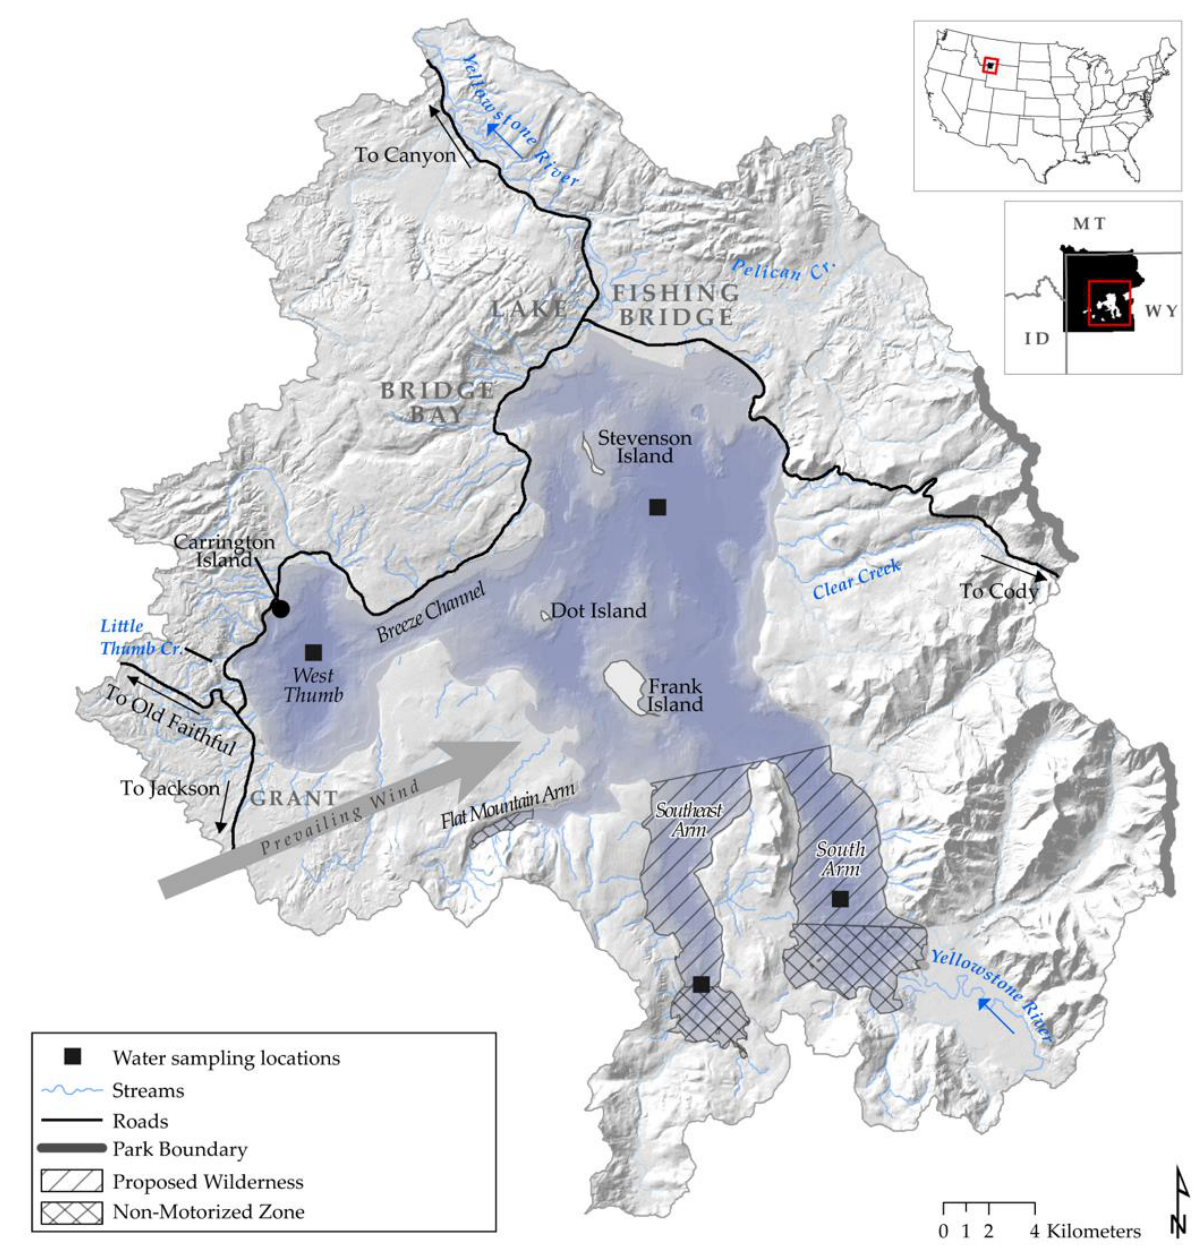
Figure 1. Yellowstone Lake within Yellowstone National Park in northwestern Wyoming, USA, with four water sampling locations indicated (West Thumb, southeast of Stevenson Island, South Arm, and Southeast Arm) and Carrington Island, where amphipod samples were collected.